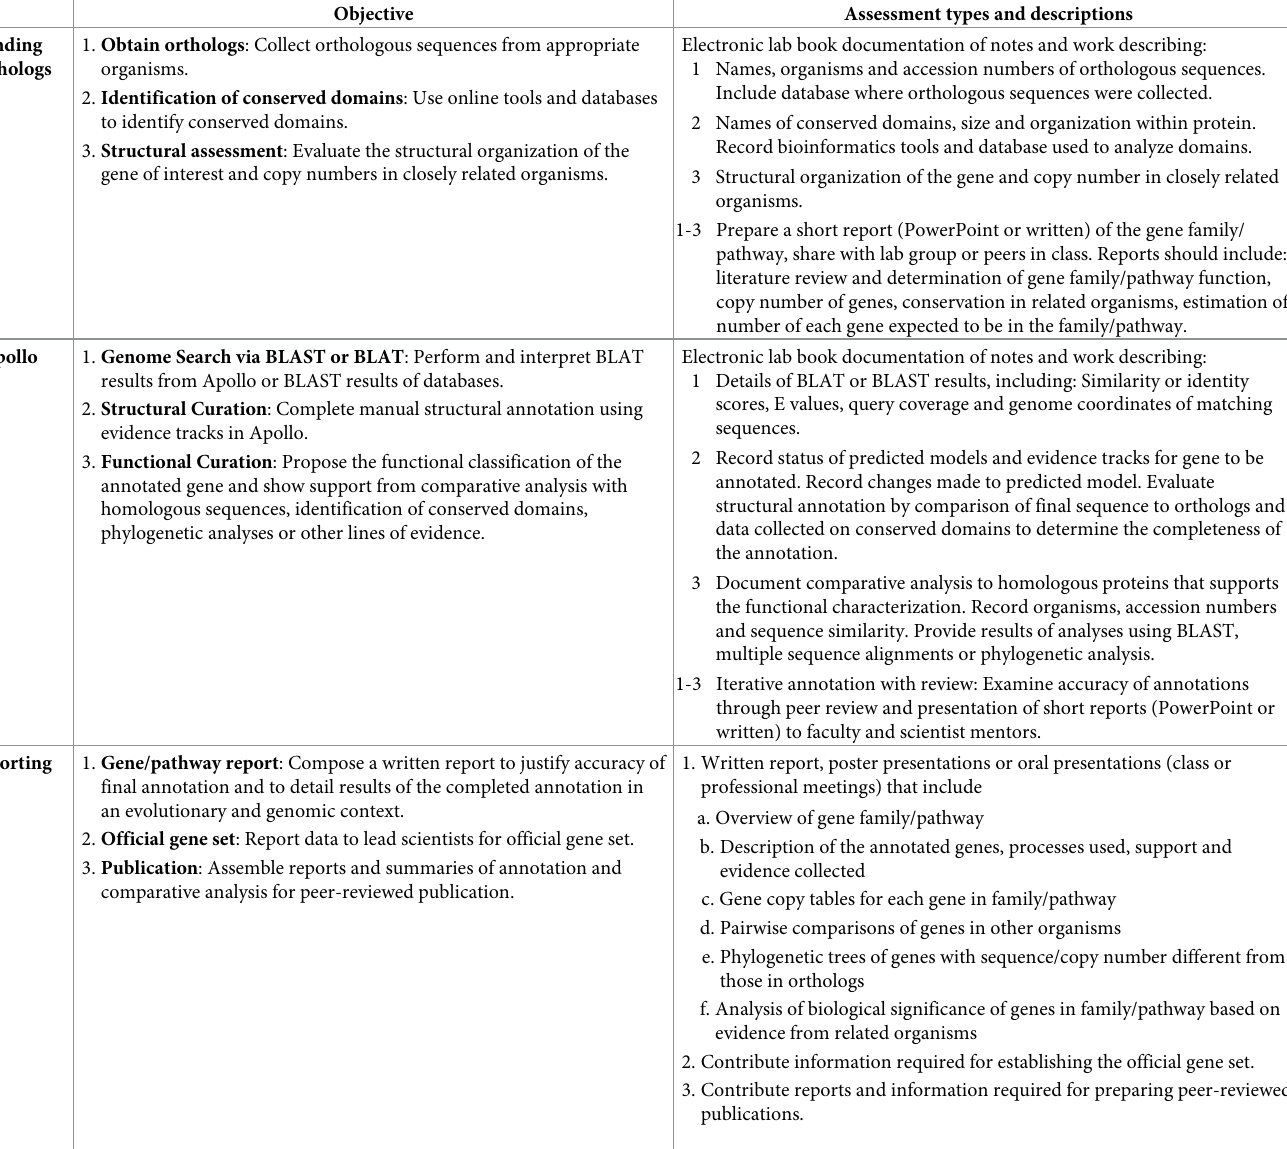
Table 2. Assessment plan for students with description of student objectives and related assessments to measure student annotation progress and quality. Objec- tives are outlined to ensure students follow the workflow in Fig 1. Students should be able to perform the activities at each step before starting the next phase of the work- flow. Objective numbers correspond to the appropriate assessment type and